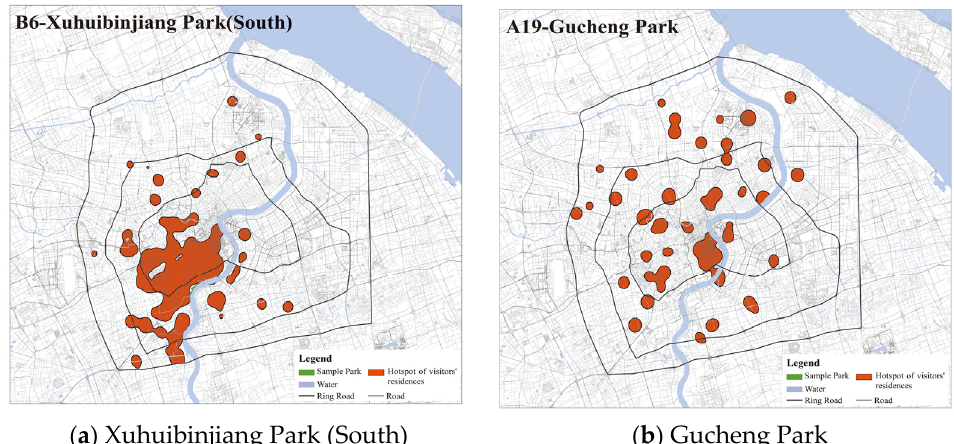
Figure 5. Hotspots of park visitors’ residences calculated by KDE method.